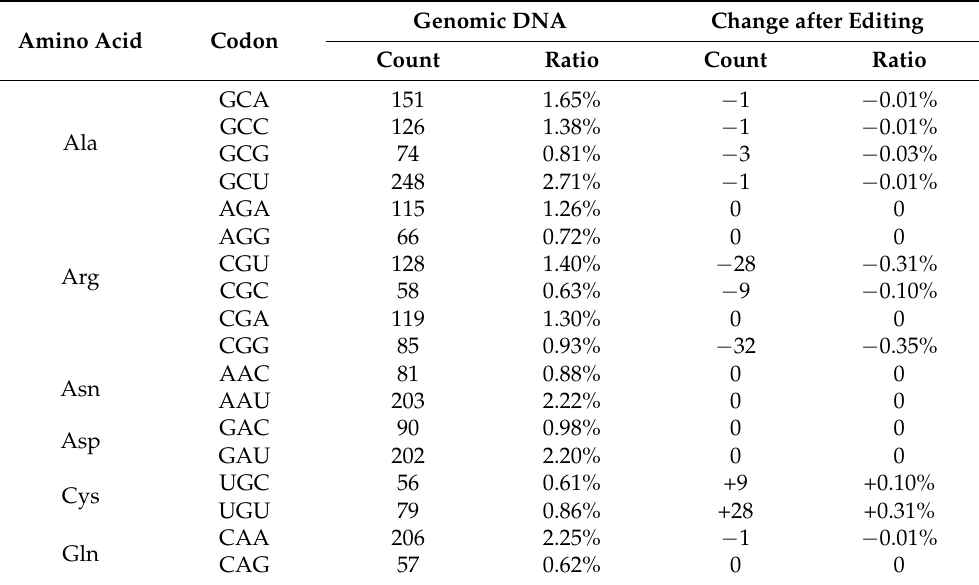
Table 4. Comparisons of codon usage before and after RNA